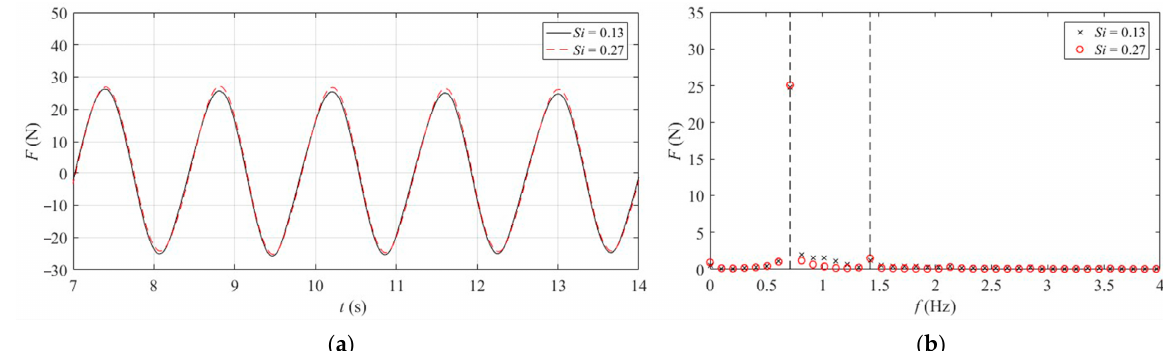
Figure 13. Load duration curve and spectrum diagram of combined structure under different levels of marine organism attachment. ( a ) Time domain curve. ( b ) Frequency domain diagram.